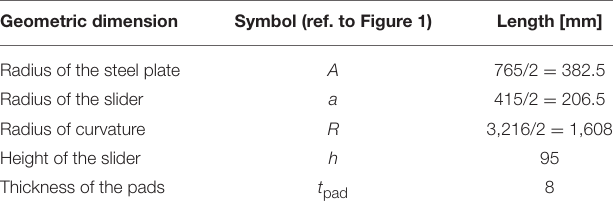
TABLE 1 | Geometrical data of the analyzed double curved surface